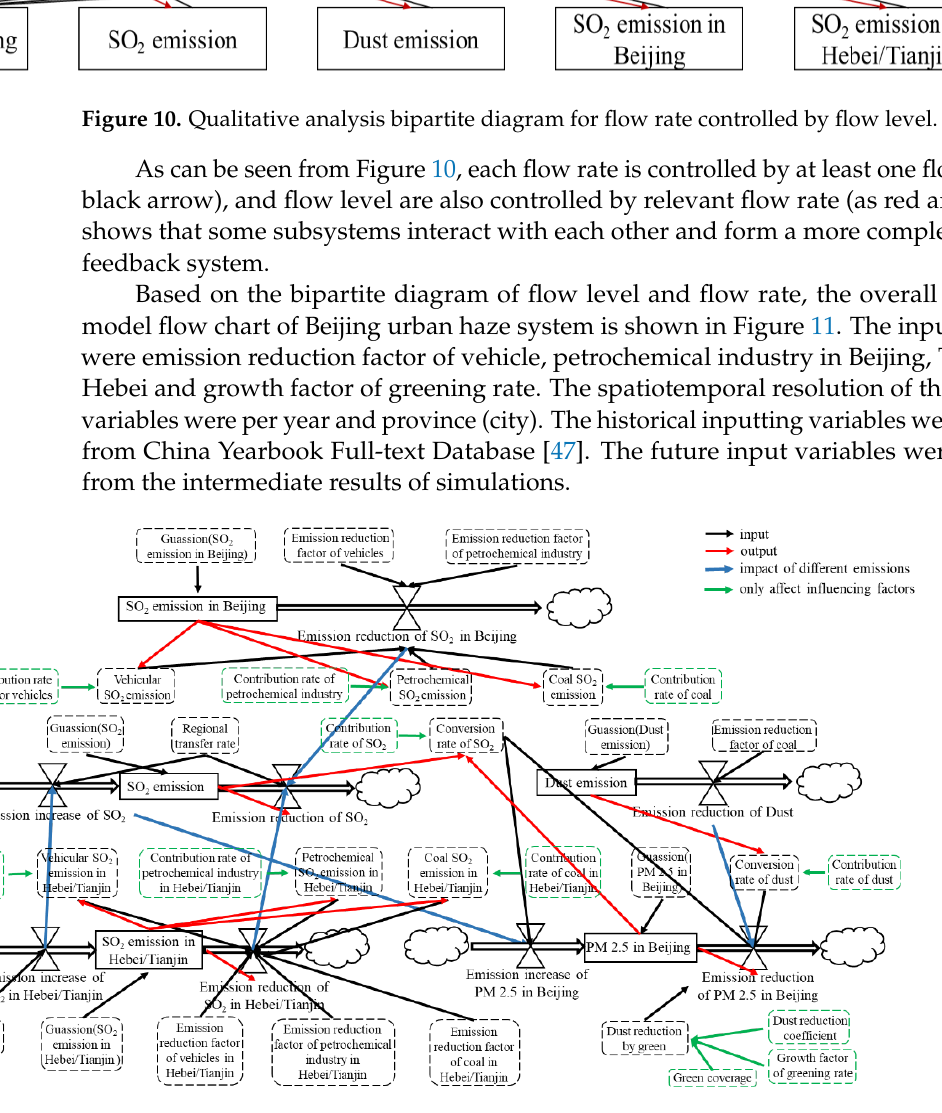
Figure 11. Overall dynamical model flow chart of Beijing urban haze system.